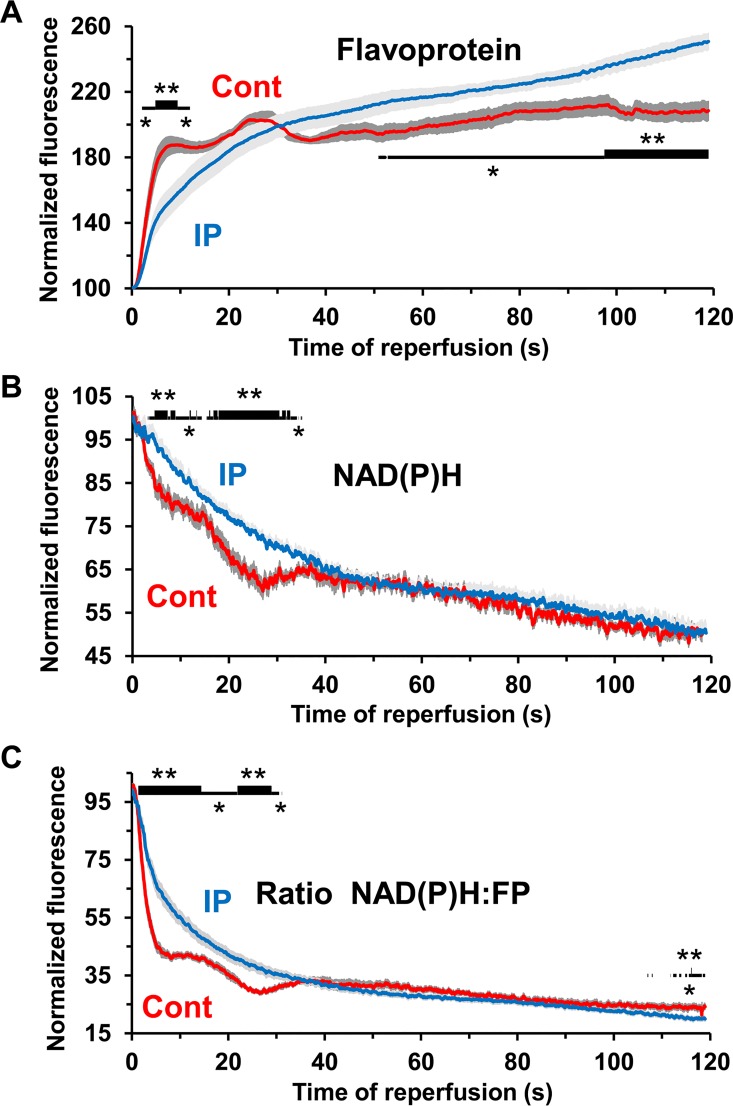
Rapid re-oxidation of NAD(P)H and flavoproteins upon reperfusion of control and IP hearts following 30 min global ischemia.Data are presented as means ± SEM (error bars) of 8 control and 9 IP hearts (* p<0.05; ** p<0.01). S2 Table presents mean data for the corresponding values at 1 min before ischemia and at 2, 10 and 30 min of reperfusion, while a full representative trace for each parameter is given in S2 Fig